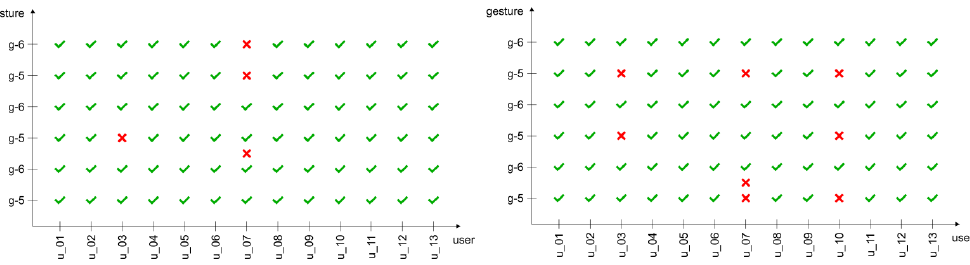
Figure 10. Detailed results for the S-6 scenario.